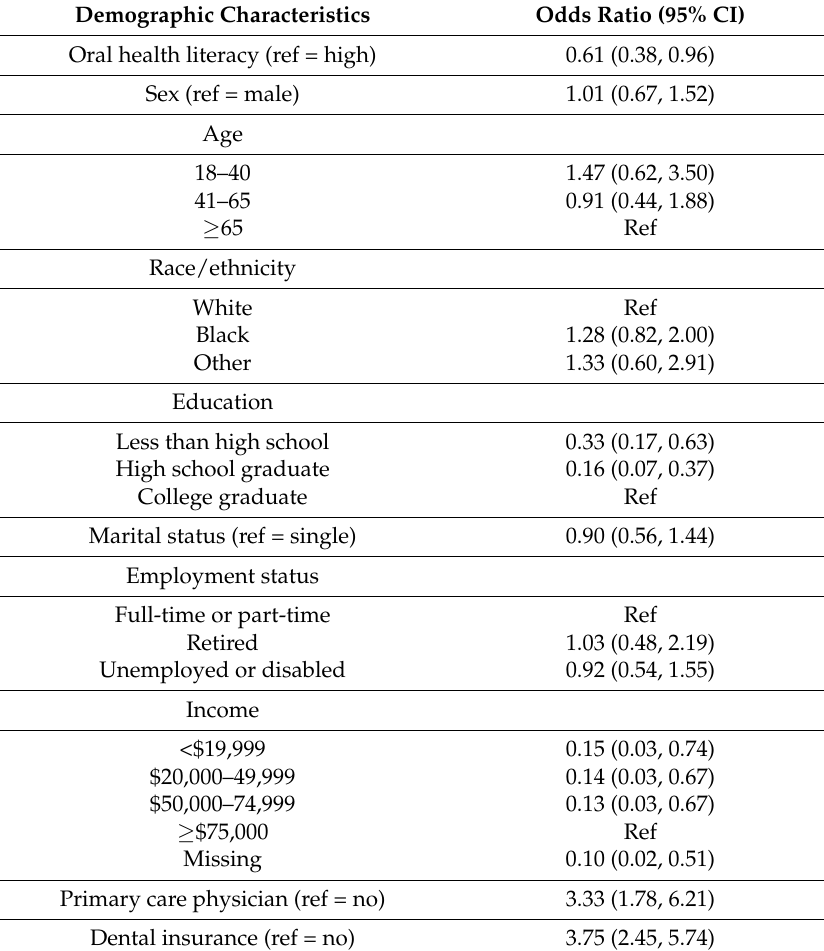
Table 3. Logistic regression predicting a dental visit within the last 12